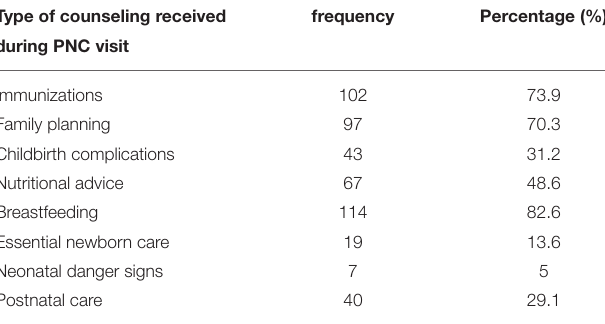
TABLE 3 | The type of counseling received by respondents during the postnatal care (PNC) visit at Chole woreda, Ethiopia in 2019 ( n =